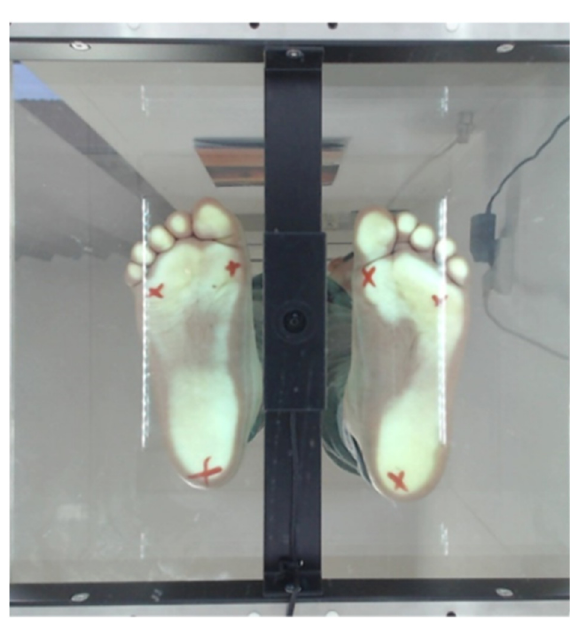
Figure 2. Plantogram picture (left spastic hemiparesis patient).